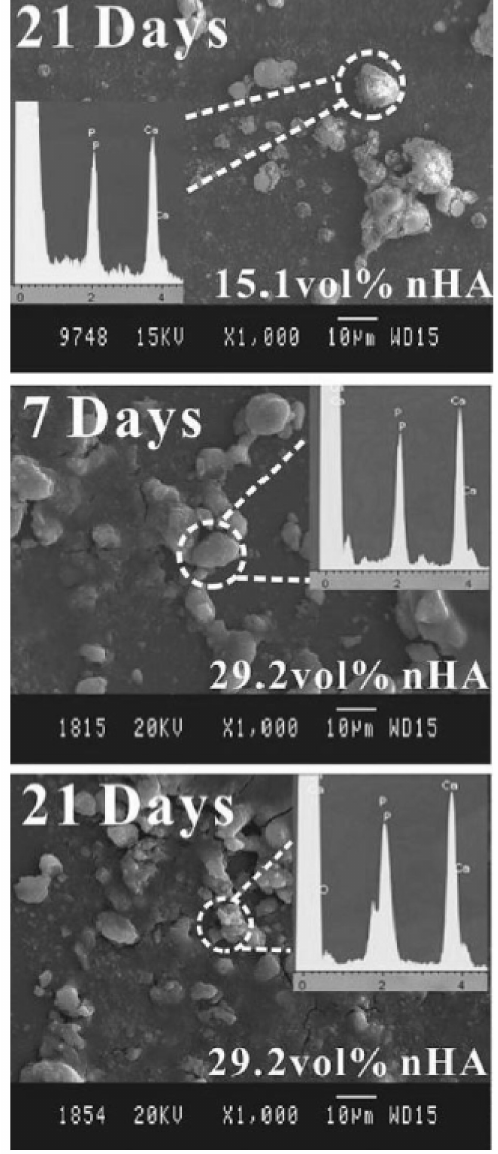
Figure 12. SEM micrographs after immersion in SBF on the 15.1 vol% nHA/PEEK and 29.2 vol% nHA/PEEK nanocomposites. The deposition of the apatite mineral layer is